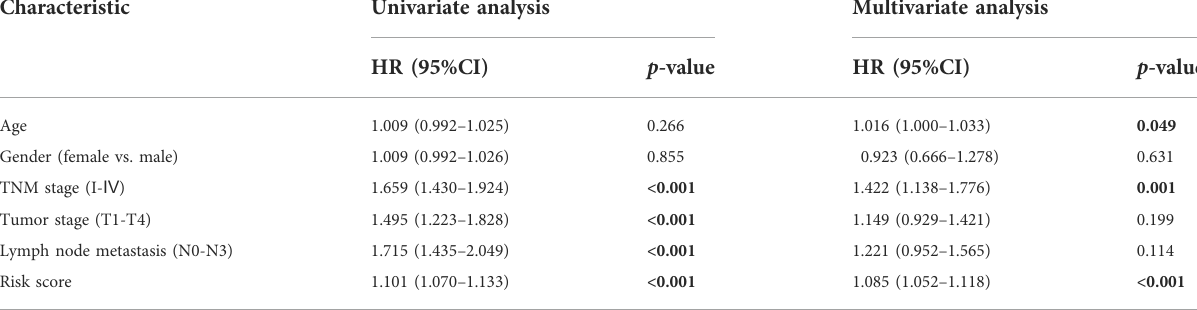
TABLE 3 Univariate and multivariate Cox proportional hazards regression analyses results of 5-lncRNA signature and other clinical risk factors in the “ entire dataset ” .